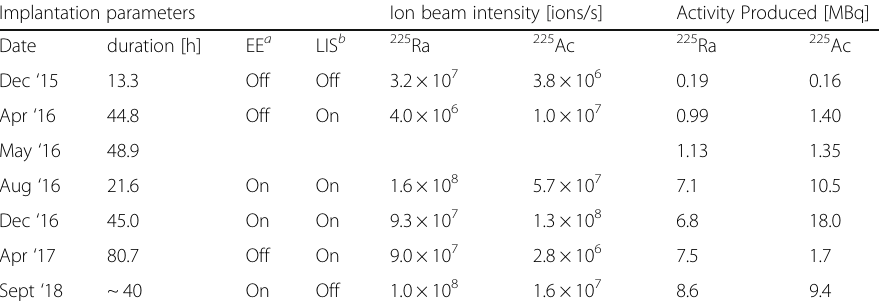
Table 1 Summary of 225 Ra and 225 Ac production runs at ISAC, TRIUMF ’ s ISOL facility. a EE = extraction electrode; b LIS = laser ionization source Implantation parameters